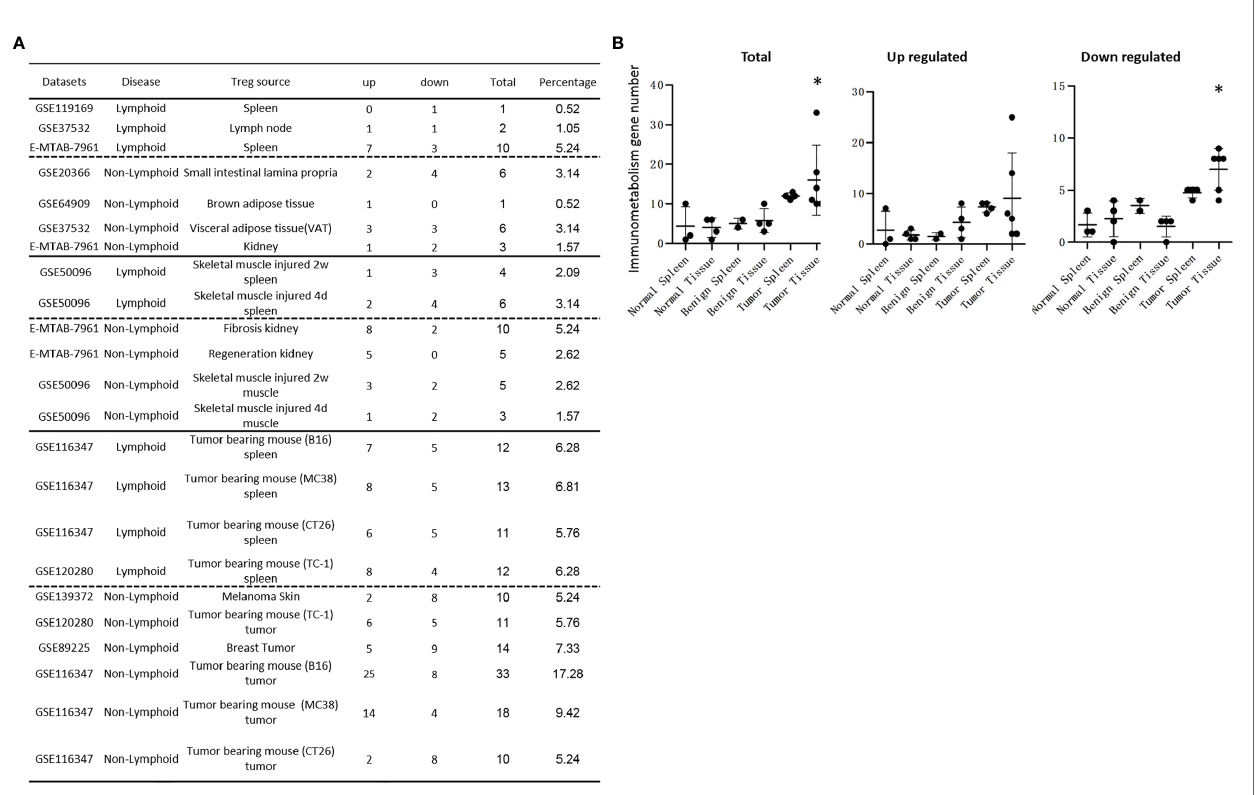
FIGURE 9 | (A) Tumor tissue Treg groups upregulate more immunometabolism enzymes than other normal tissue Treg groups and benign disease tissue Treg groups. A total of 191 immunometabolism enzyme genes were screened in all the Treg groups. Downregulated and total immunometabolism gene numbers were more in tumor tissue Treg groups than in other Treg groups. (B) There were more differentially expressed immunometabolism enzyme genes in tumor tissue Treg groups than other Treg groups. The total regulated immunometabolism gene numbers were more in tumor tissue Treg groups than that in normal tissue Treg groups and diseased tissue Treg groups, p = 0.03. The upregulated immunometabolism gene numbers had no difference between Treg groups. The downregulated immunometabolism enzyme genes were more in tumor tissue Treg groups than other Treg groups, p < 0.05. *Signi fi cantly